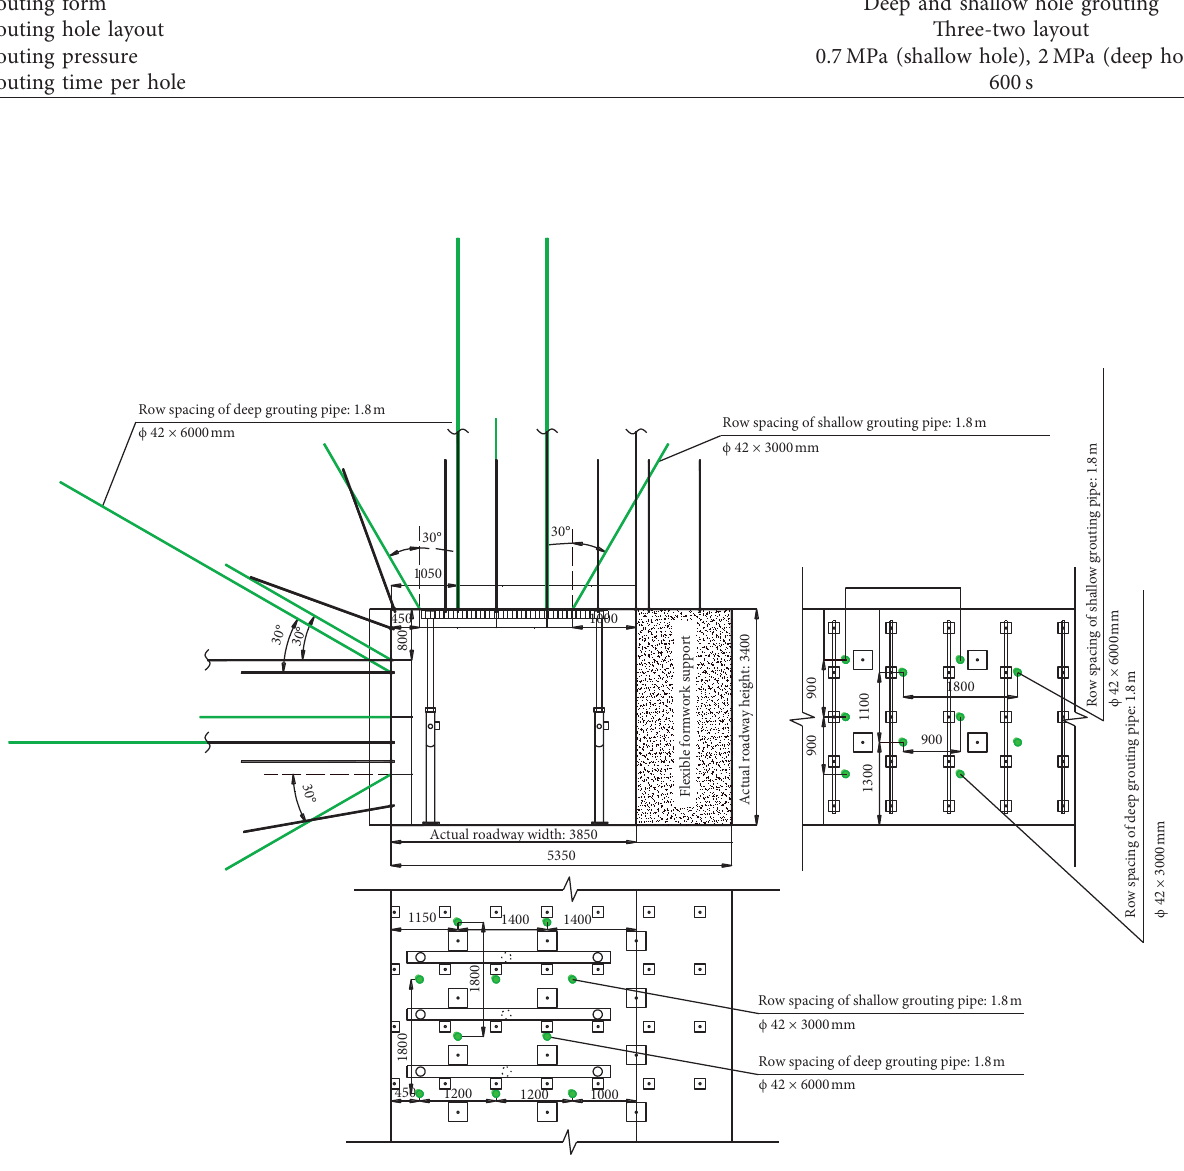
Figure 7: The layout of the grouting hole.